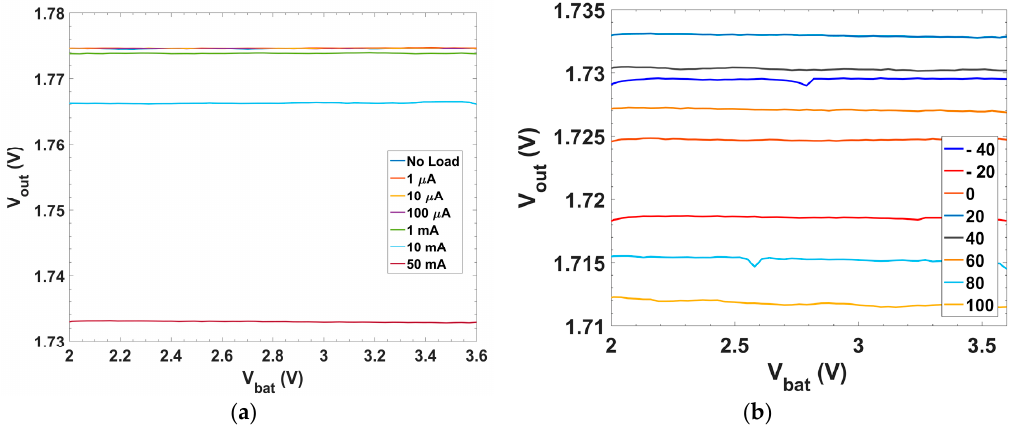
Figure 10. Line regulation characteristic, i.e., output voltage vs. input voltage: ( a ) for different load currents; and ( b ) for different temperatures under maximum load current condition.